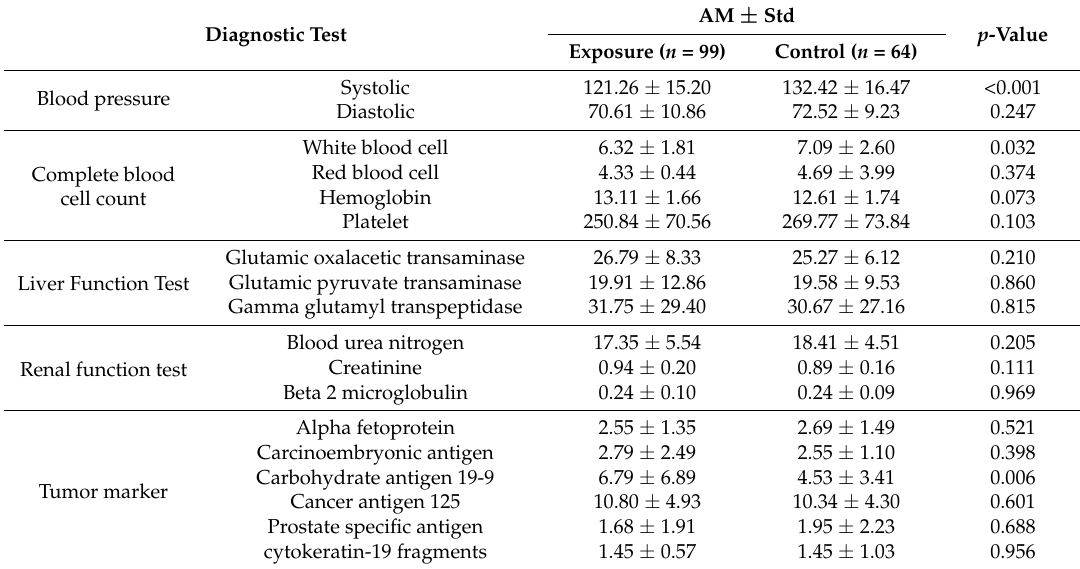
Table 5. Comparison of the diagnostic test results between the adult exposure and control groups.